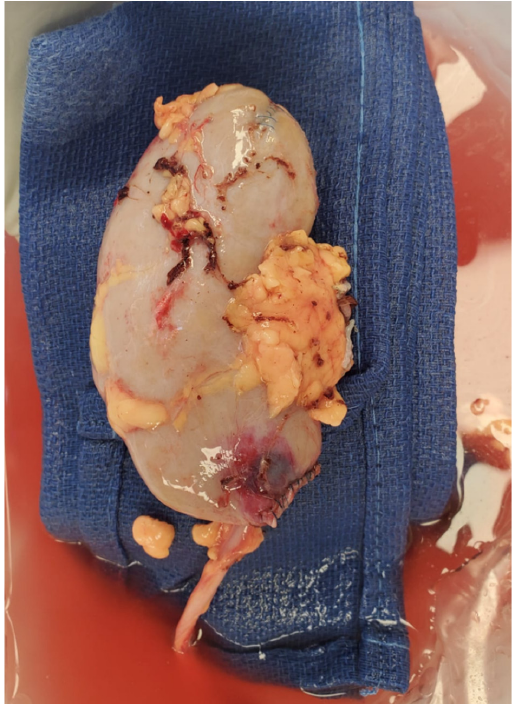
Figure 4. Picture of the explanted left kidney after backbench organ preparation. Note that the lower pole fibrotic band has been reinforced with a hemostatic running suture.